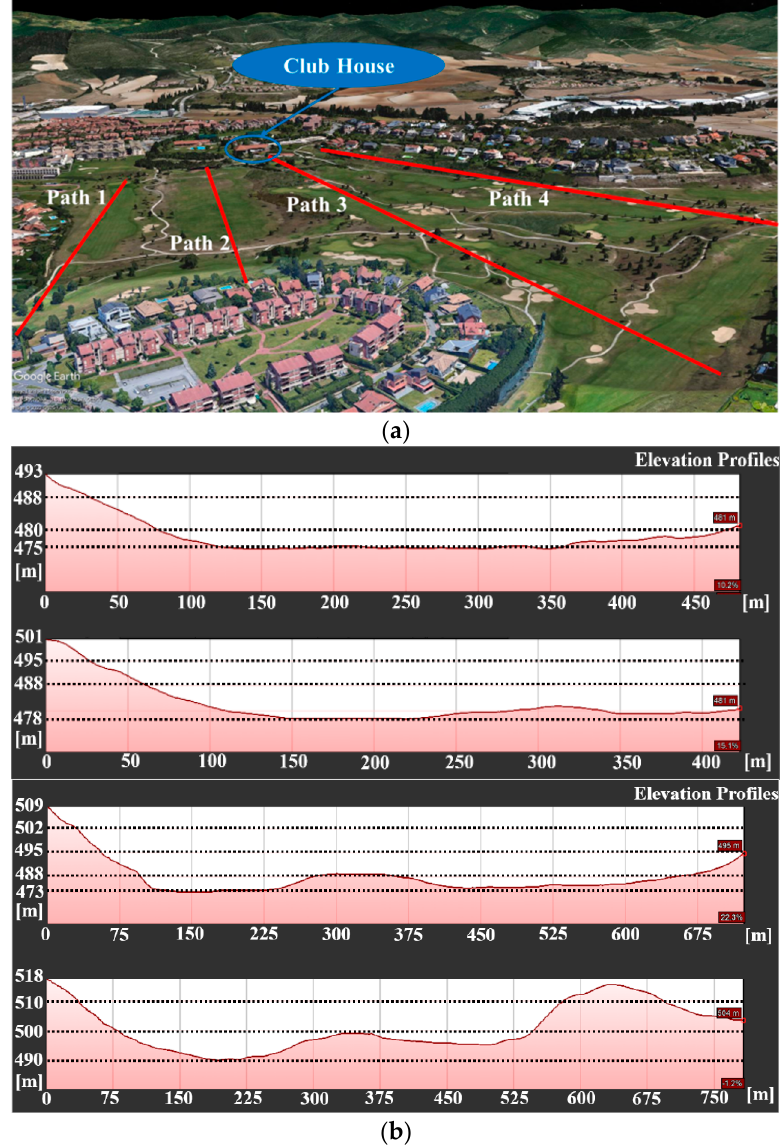
Figure 2. Elevation profiles of the golf course: ( a ) General Google Earth picture of the course; ( b ) Elevation profiles for Paths 1, 2, 3 and 4.